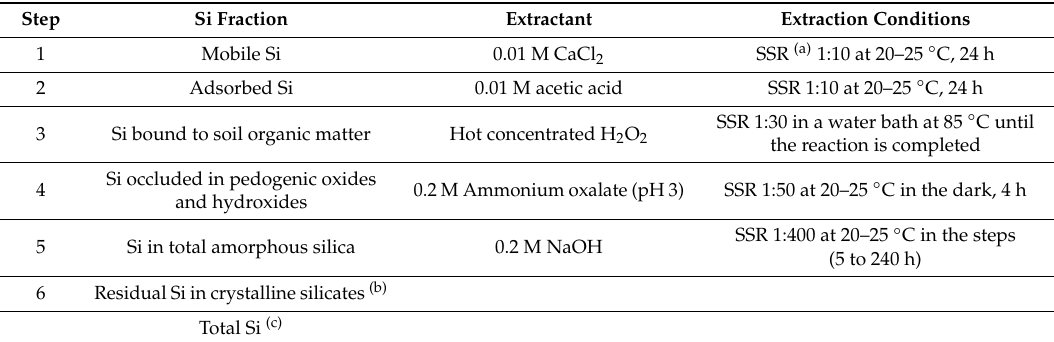
Table 3. Modified sequential extraction procedure for Si fractions in